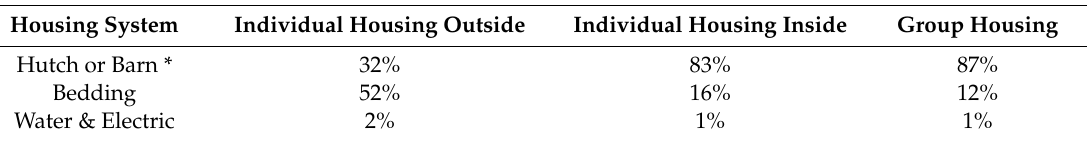
Table 3. Percentage breakdown of hutch / barn infrastructure, bedding and, water and electric on total housing cost per housing management